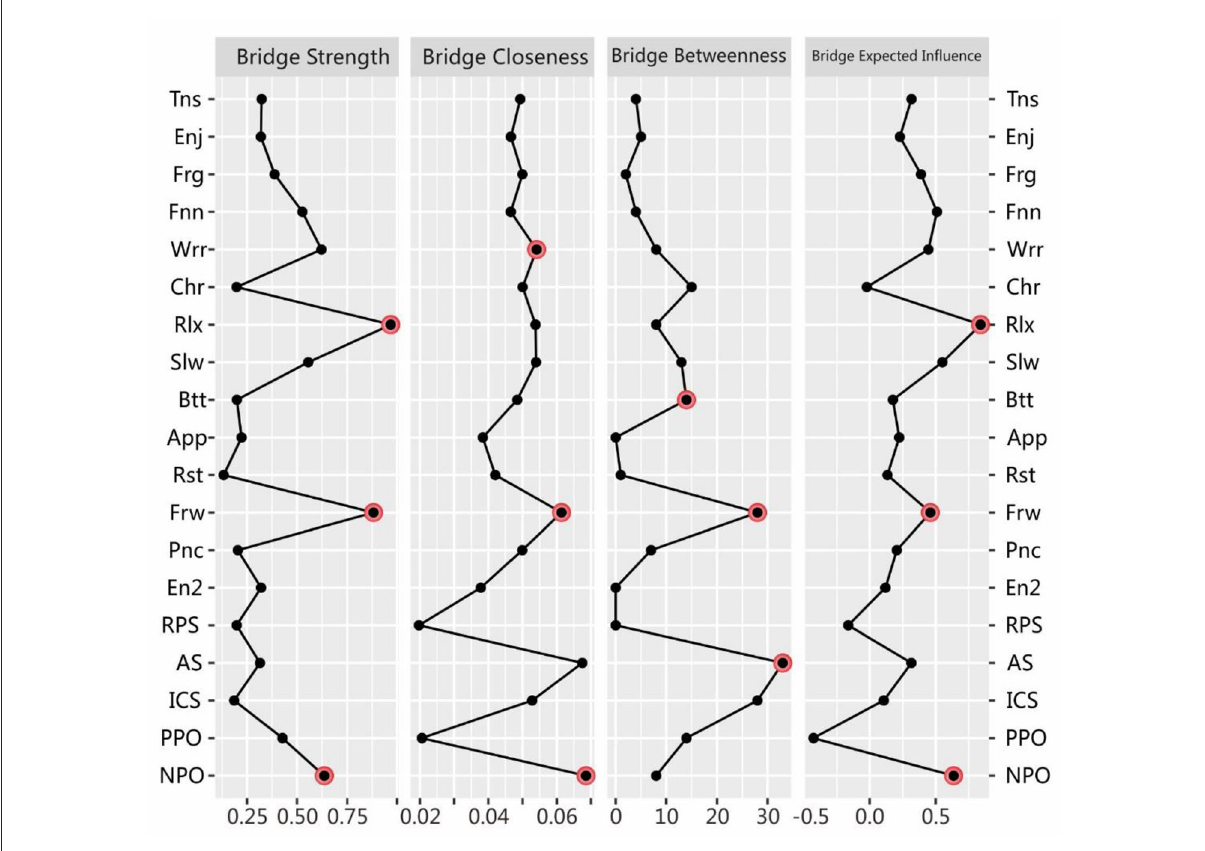
FIGURE3 Estimated bridge centrality indices for the present network, including bridge strength, bridge betweenness, bridge closeness, and bridge expected influence. The full names of the abbreviations for the nodes can be found in Figure 1.